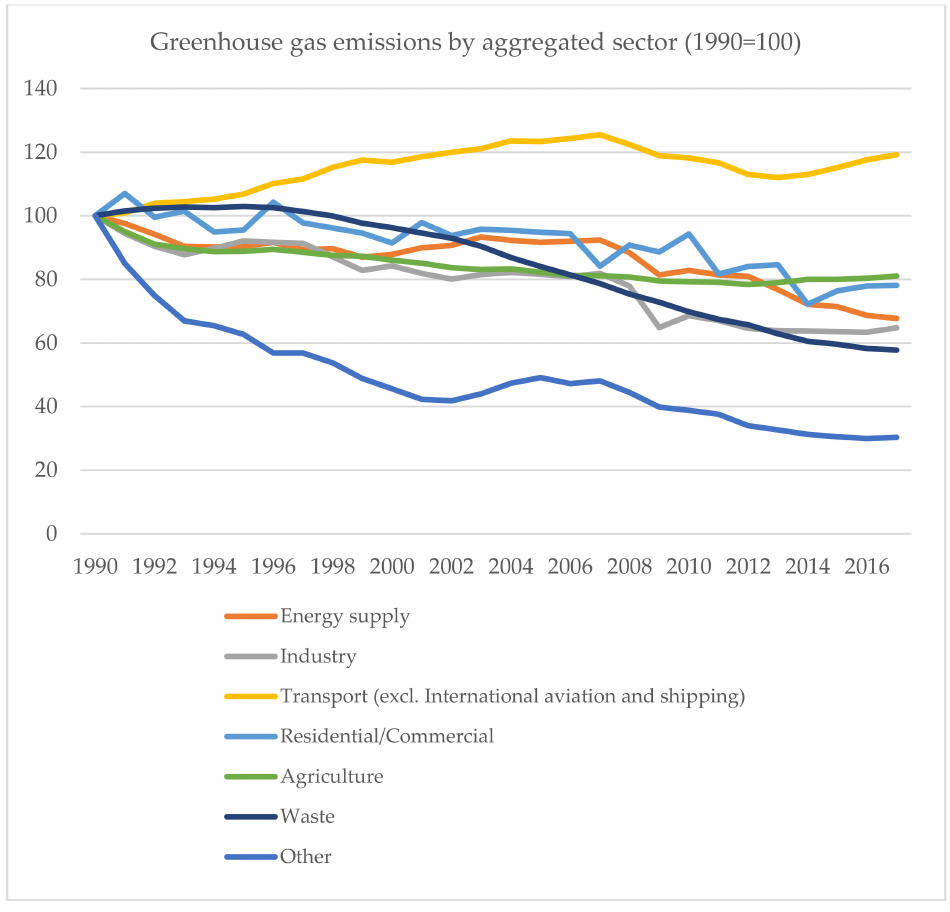
Figure 1. CO 2 emissions in European Union